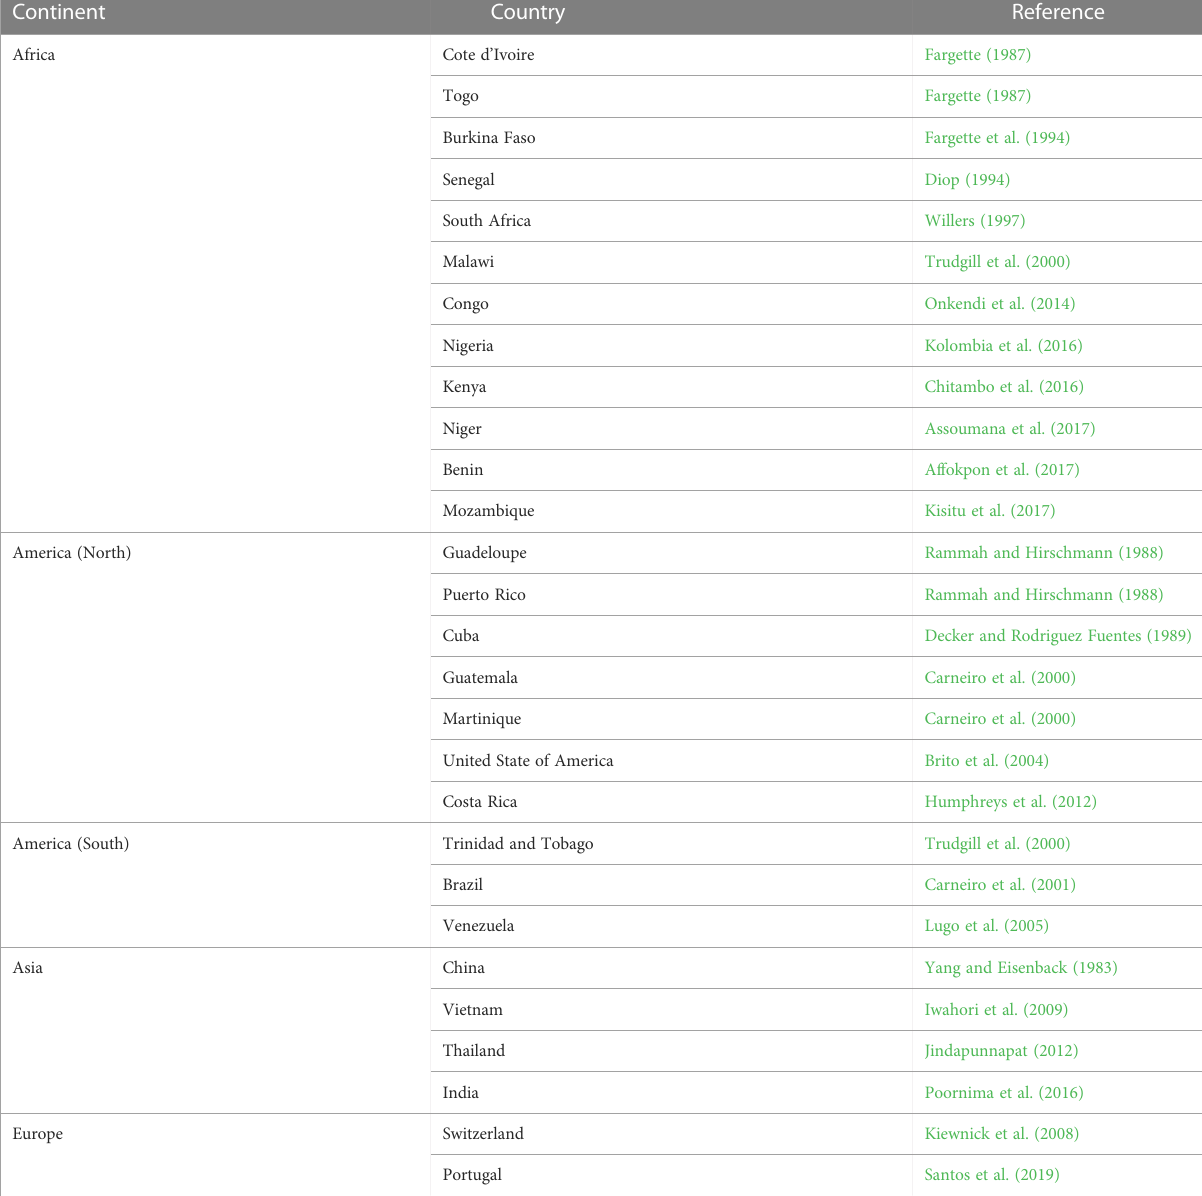
TABLE 1 Geographic distribution of Meloidogyne enterolobii . Continent